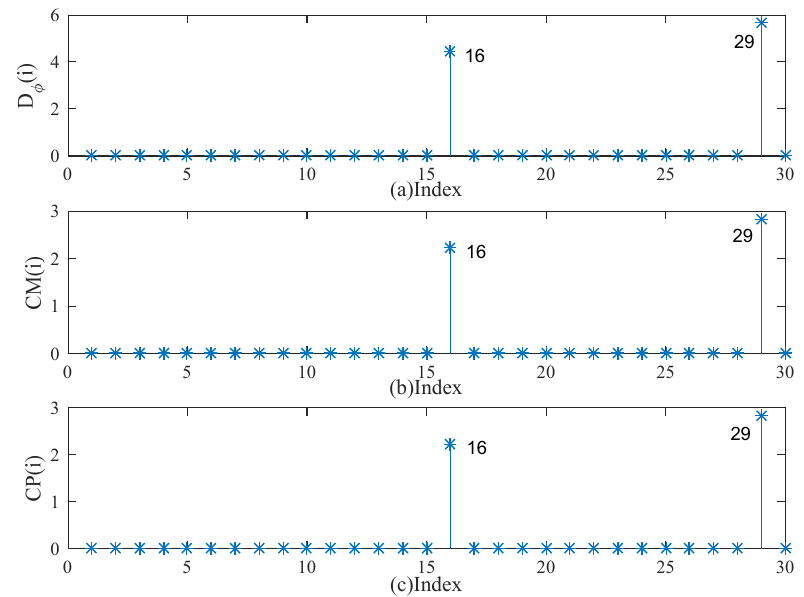
Figure 4. Diagnostic plots of covariate outliers in Simulation 3.